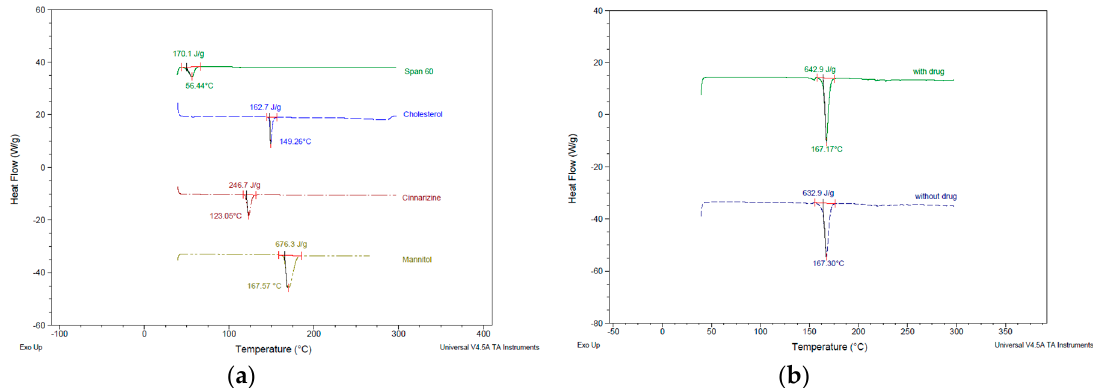
Figure 9. Differential Scanning Calorimetry (DSC) thermographs for ( a ) pure raw materials for niosomes formulation compositions and mannitol as lyoprotectant; ( b ) freeze-dried formulations 3 and 4.